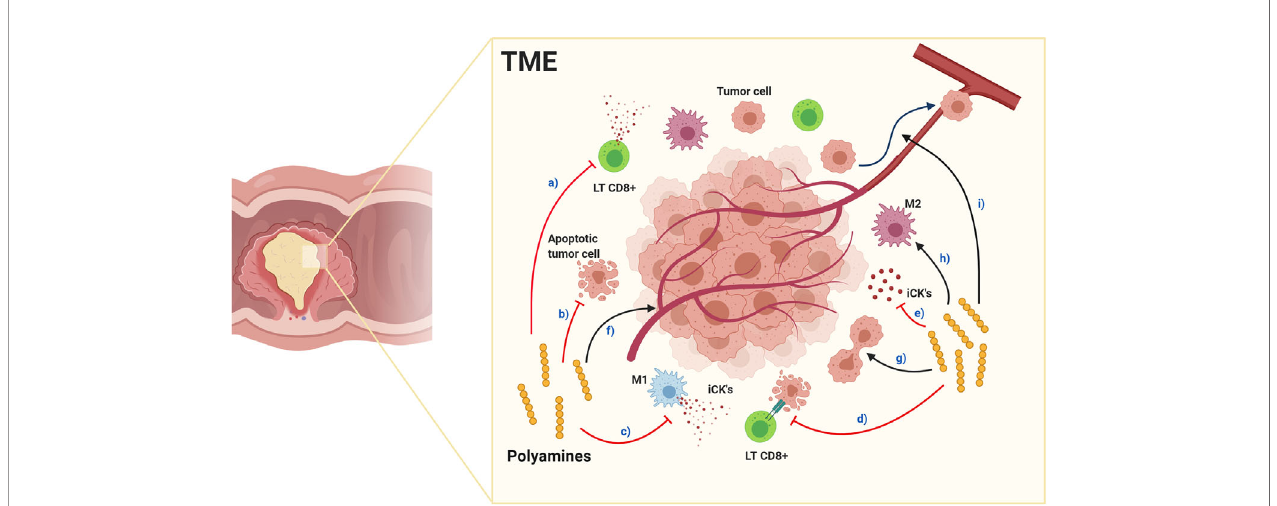
FIGURE 4 | Effects of polyamines in the tumor microenvironment. Red arrows indicate inhibition and black arrows enhancement. Polyamines in TME: a) inhibit cytotoxic CD8+ LTs function and decrease quantity, inhibit: b) tumor cell apoptosis, c) macrophage polarization toward M1 pro-in fl ammatory phenotype, d) antitumor responses and e) pro-in fl ammatory cytokine production. Alternatively, polyamines enhance: f) tumor angiogenesis, g) tumor cell proliferation, h) macrophage polarization toward M2 immunosuppressive phenotype and i) tumor cell metastasis. Together, their effects produce an immunosuppressed environment facilitating tumor progression and